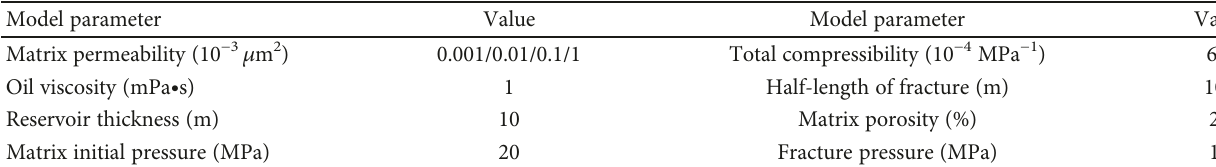
Table 3: The main parameters of the model.